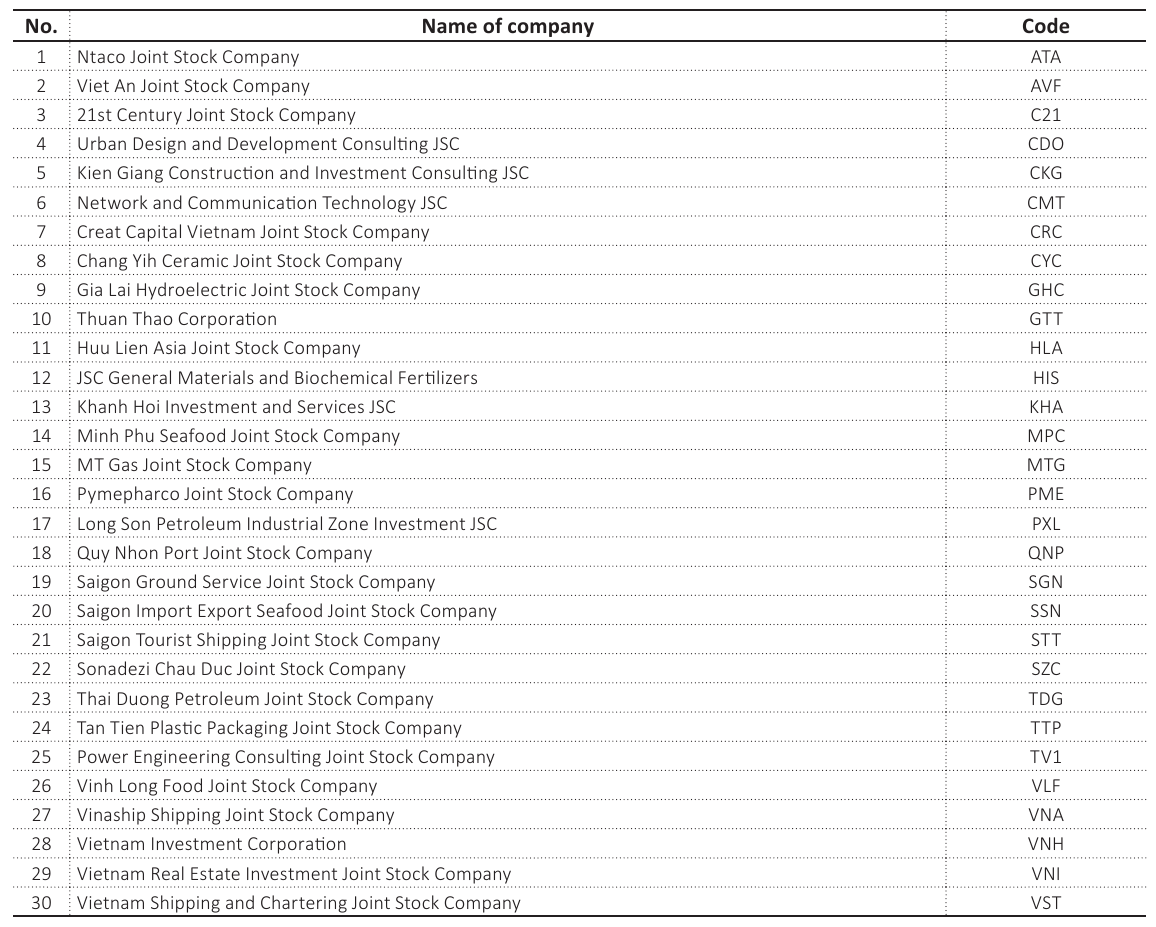
Table A2. List of 30 canceled listing companies on Vietnamese stock market from 2015 to